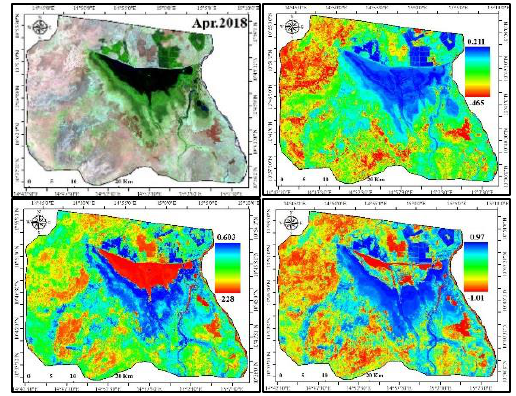
Figure 4. Visual patterns. Left-right and top-down: Landsat image, NDWI, SAVI and VMI.